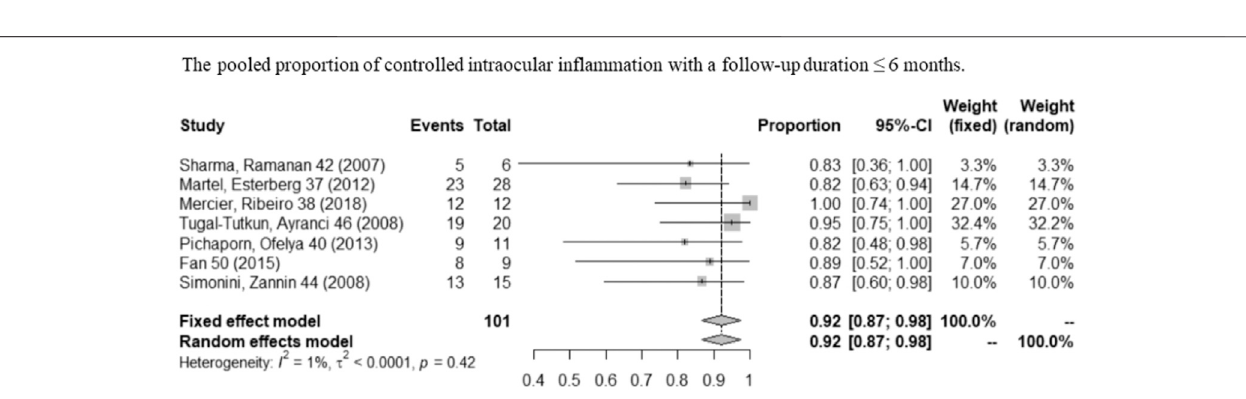
Frontiers in Pharmacology |